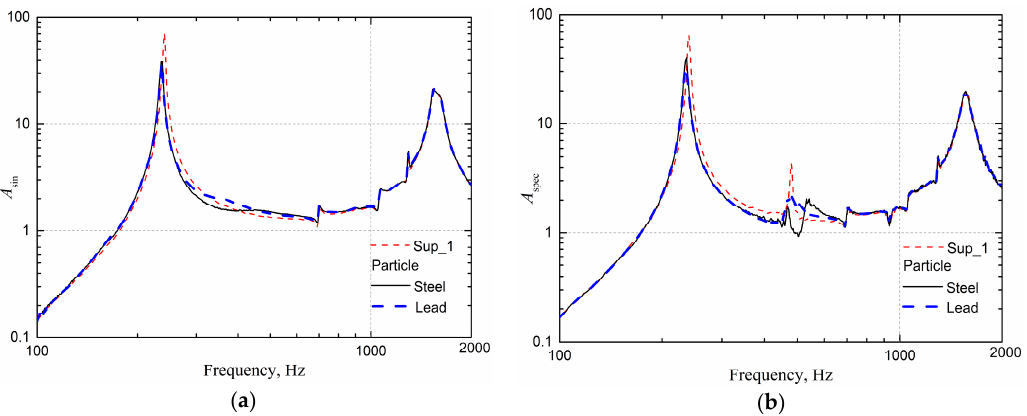
Figure 15. Experiment results of particle material: ( a ) Sinusoidal excitation; ( b ) Random excitation.